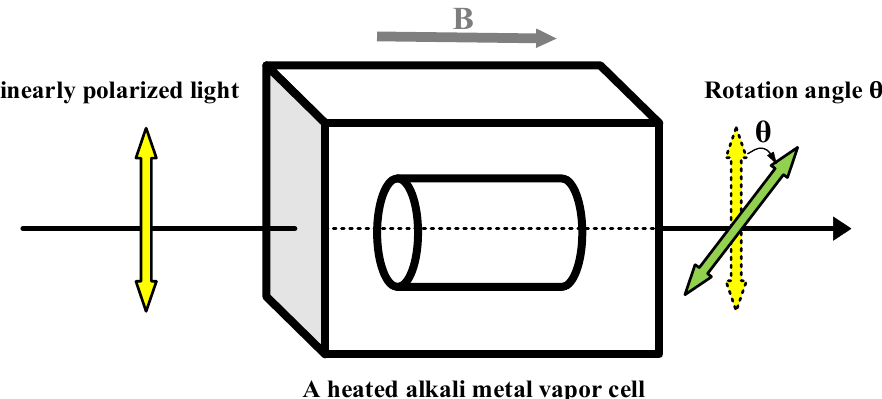
Figure 3. Rotation of polarization plane of light, as it travels through a heated alkali metal vapor cell placed in a magnetic field.